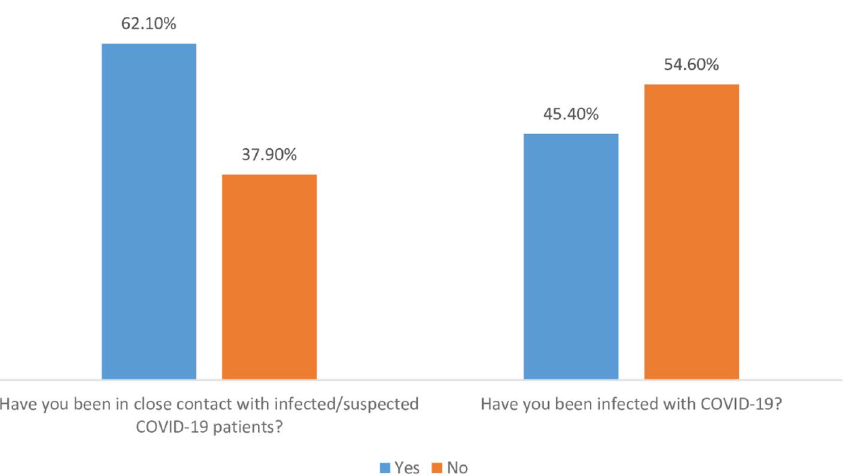
Figure 5. Pregnant women declaration on their close contact with COVID-19 patients and their infection rate by